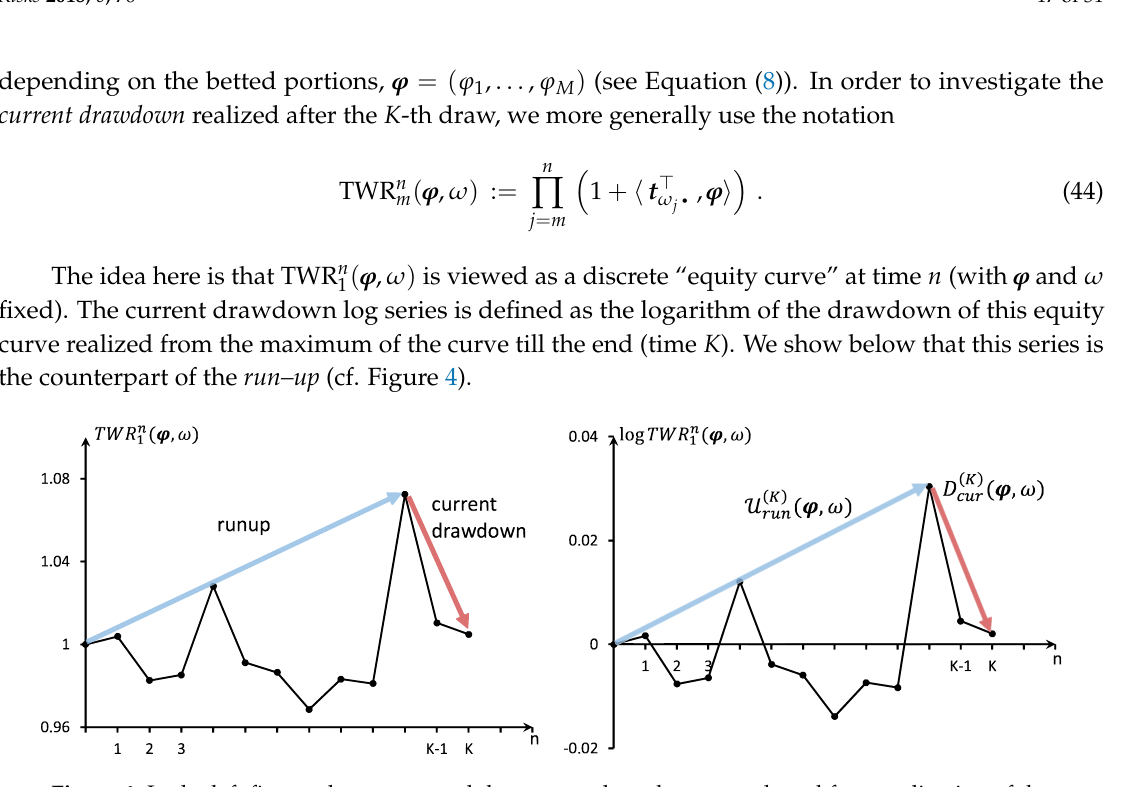
Figure 4. In the left figure, the run-up and the current drawdown are plotted for a realization of the TWR “equity”-curve and, to the right, are their log